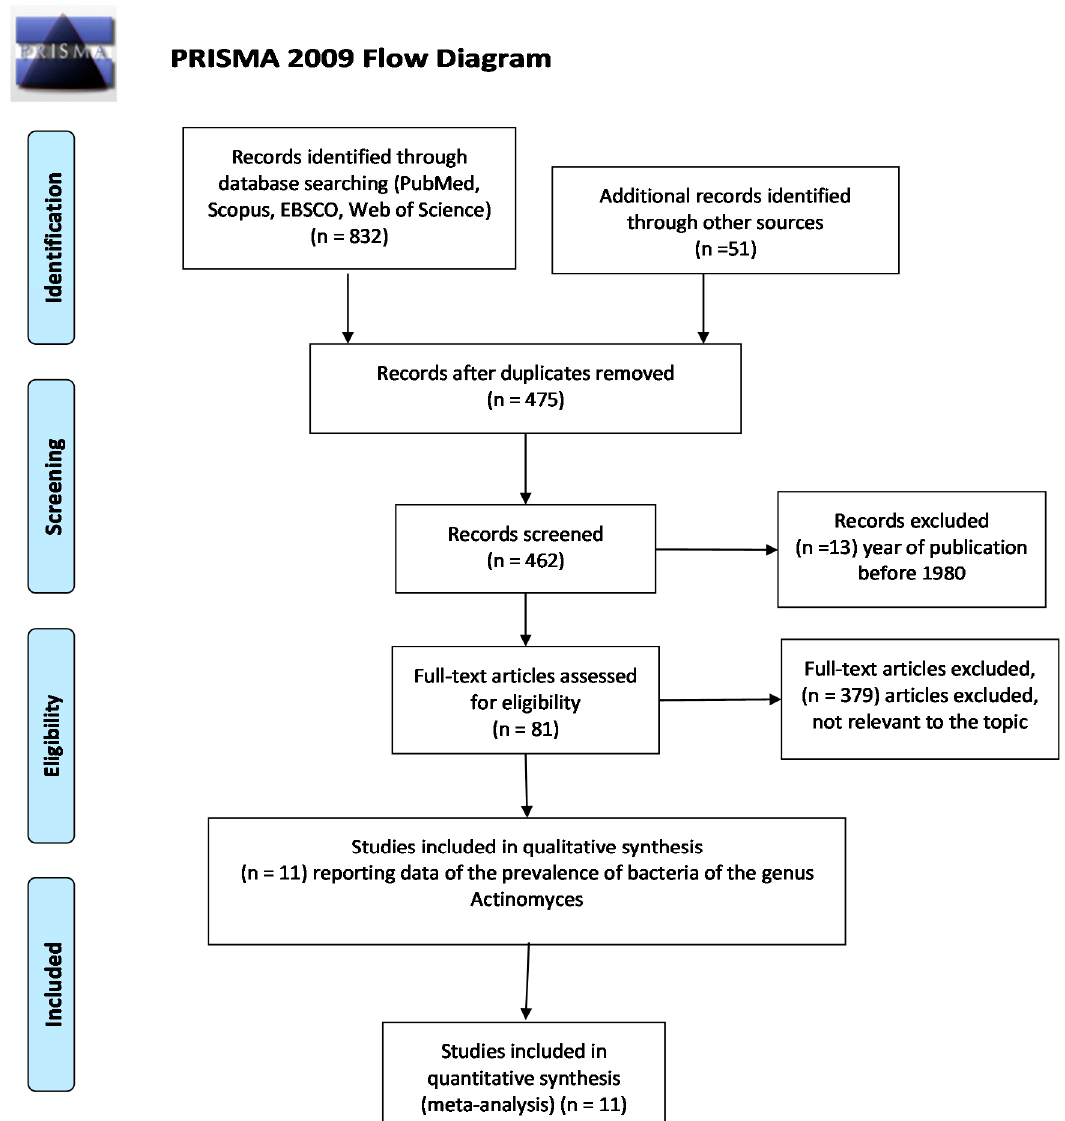
Figure 1. Flowchart of the different phases of the systematic review.